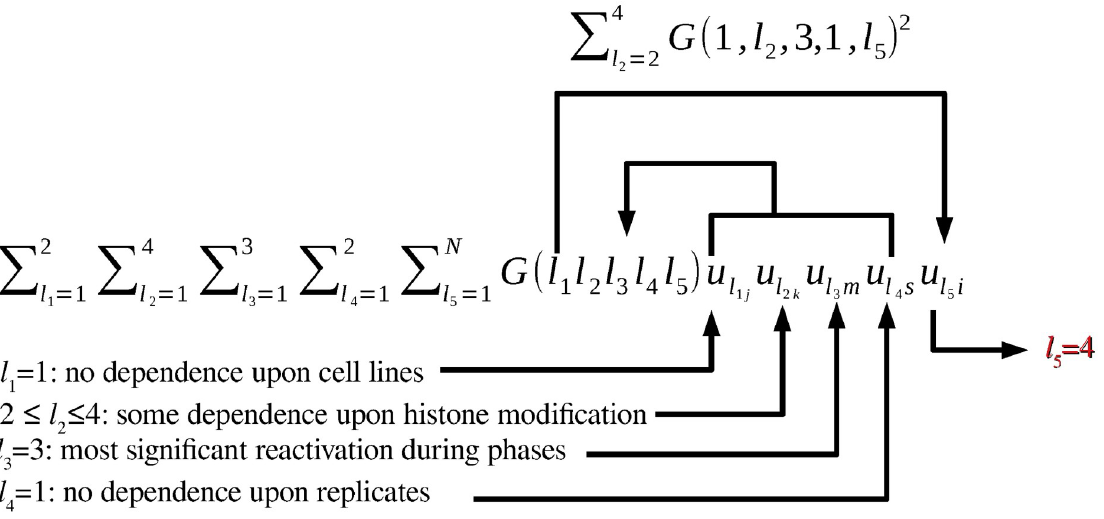
Fig 4. Schematic of the process for selecting u 4 i to be used for DNA region selection.